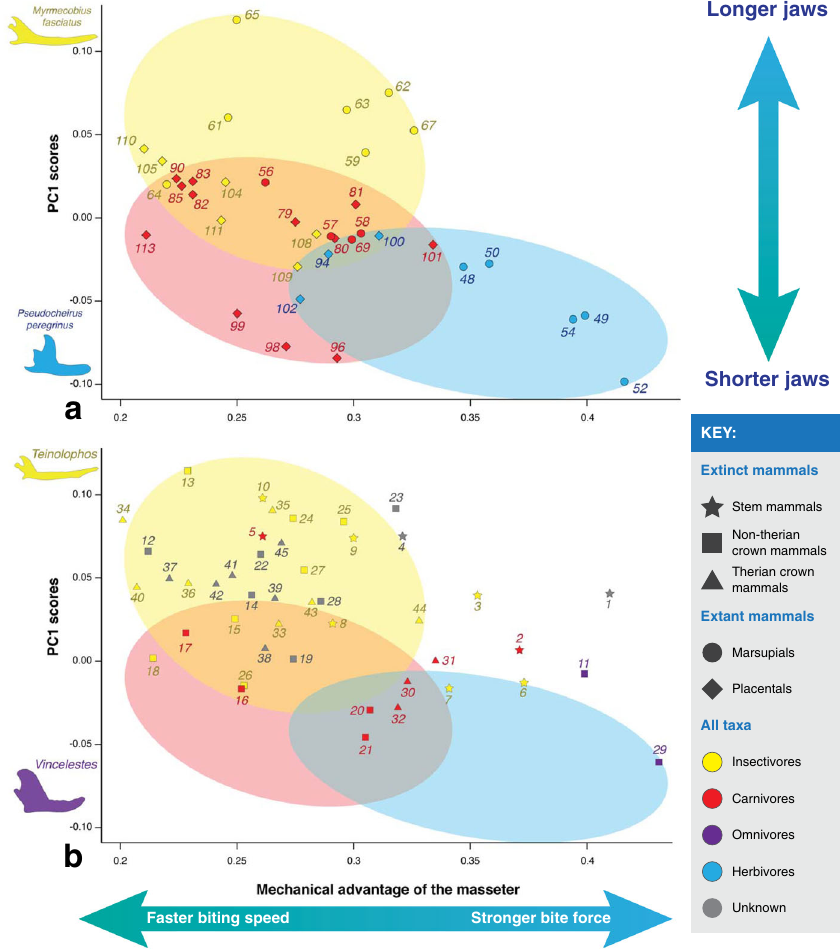
Fig. 6 Scatter plot of the mechanical advantage of the masseter ( x axis) vs. PC1 scores from Fig. 3 ( y axis), which mainly describes jaw length. a Extant taxa, b extinct taxa. Colors indicate known dietary categories of extant mammals and suggested dietary categories for Mesozoic mammals (obtained from the literature). Ovals indicate where extant taxa of known dietary categories plot, as in part a